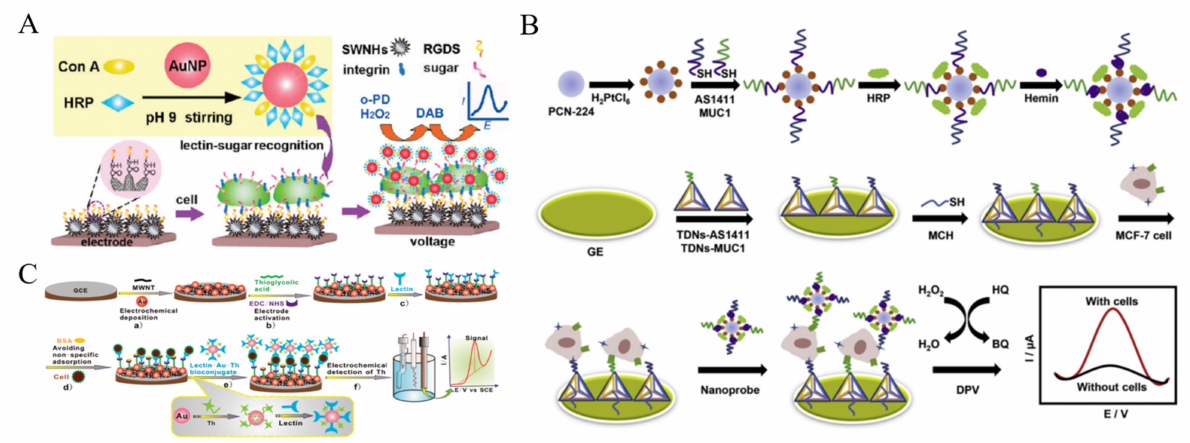
Figure 9. ( A ) Schematic representation of nanoprobe assembly and electrochemical strategy for in situ detection of cells and mannose groups on living cells [167]. Copyright 2010 American Chemical Society. ( B ) Schematic representation of fabrication procedures of PCN-224-Pt/HRP/dual-aptamer/GQH nanoprobe and the electrochemical dual-aptamer cytosensor fabrication process [173]. Copyright 2019 Elsevier B.V. ( C ) Schematic representation of the lectin-based biosensor for EC Analysis of cells [177]. Copyright 2010 American Chemical